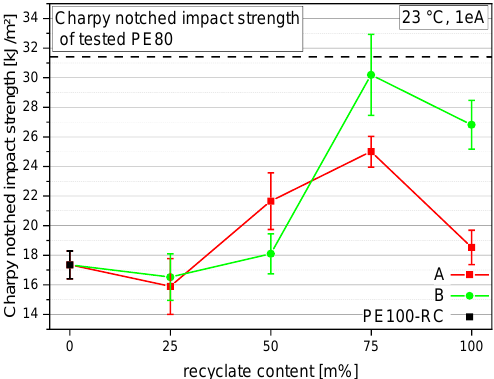
Figure 6. Graphical illustration of Charpy notched impact strength of the virgin material PE100-RC (as 0 m% recyclate content data point for both compounding series), both recyclates (at 100 m% recyclate content), and the compounds containing 25 m%, 50 m%, and 75 m% rPE-A and rPE-B, respectively. The vertical bars show the sample standard deviation.